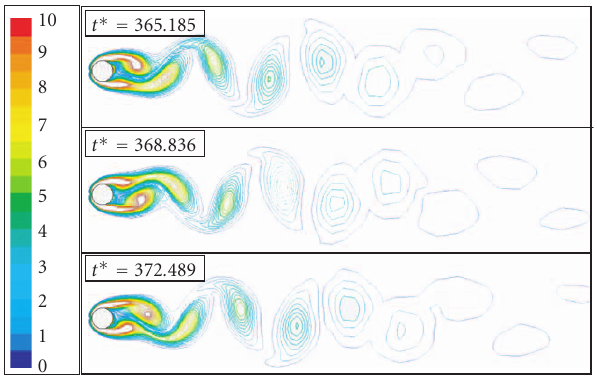
Figure 5: Vorticity shedding at three di ff erent